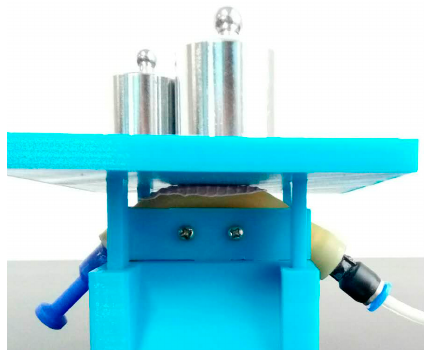
Figure 3. The experiment of force sensing.